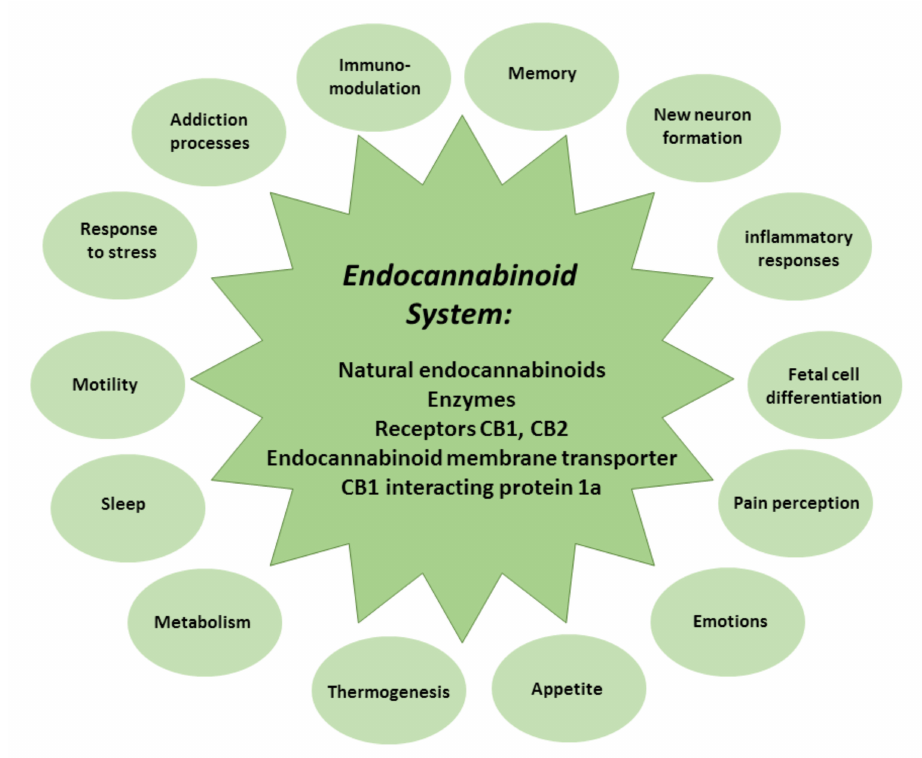
Figure 2. The composition and role of the endocannabinoid